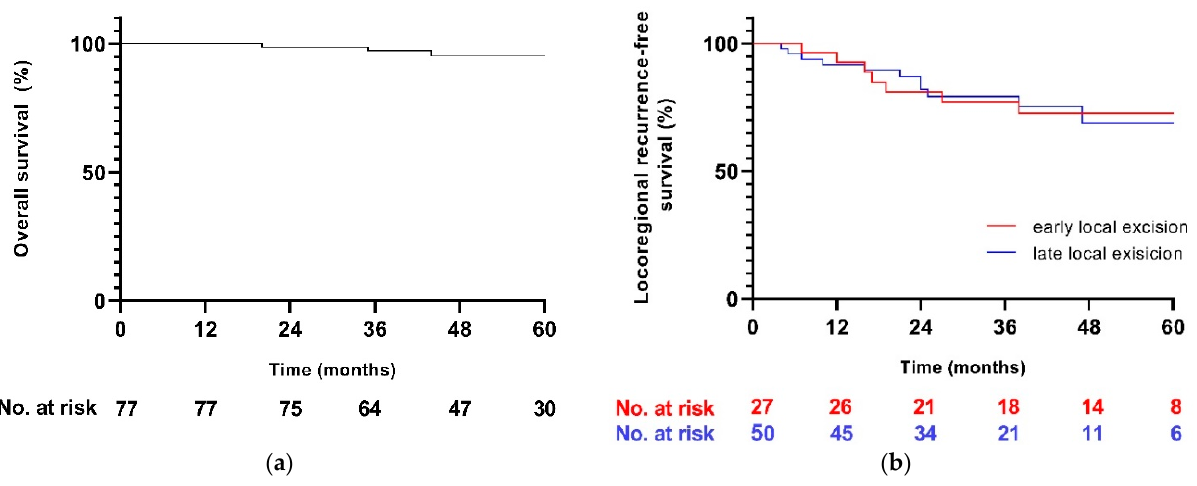
Figure 2. Kaplan–Meier curves for ( a ) overall survival and ( b ) locoregional-recurrence-free survival for the early and late local excision groups.